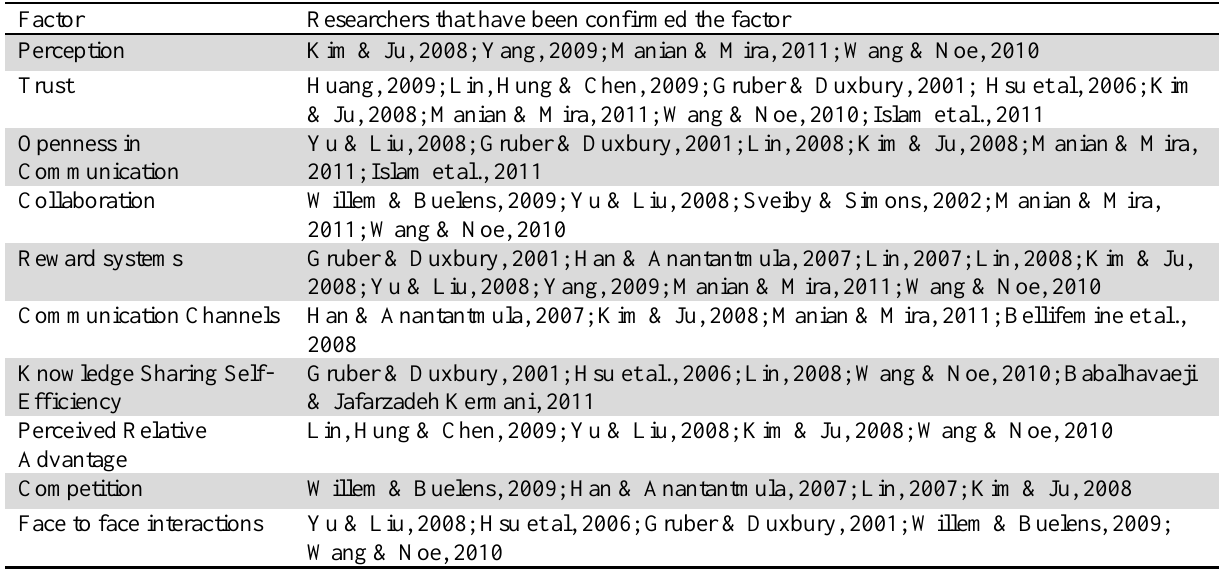
Studies conducted on the identification of the indices of knowledge sharing Researchers that have been confirmed the factor